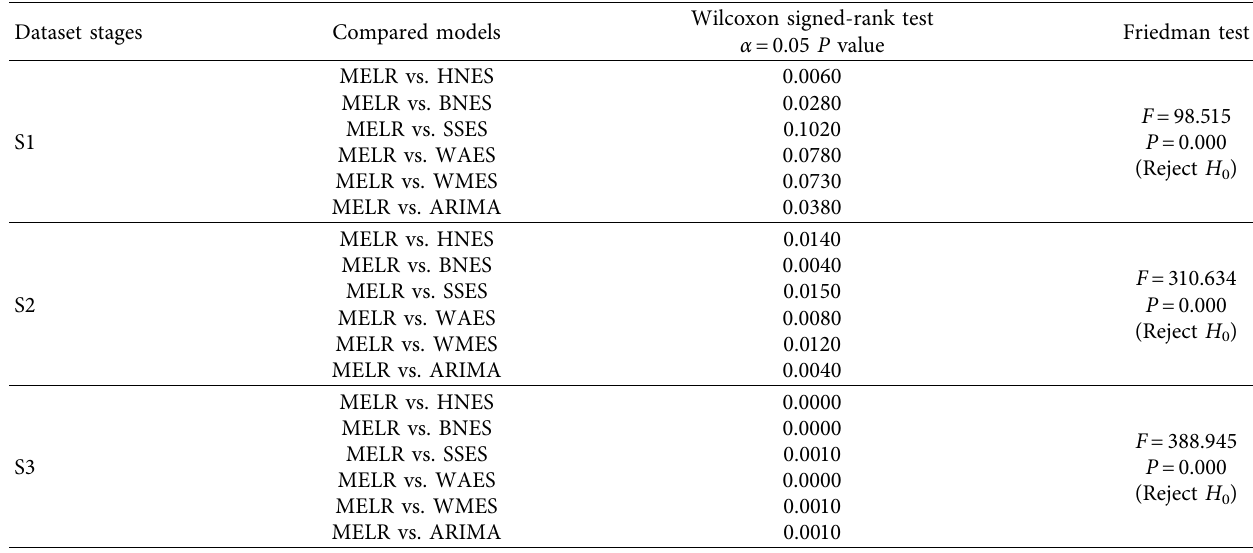
Table 6: The difference between fitting/predicted and actual daily passenger intensity and volume in MELR and ARIMA models. Stages and models